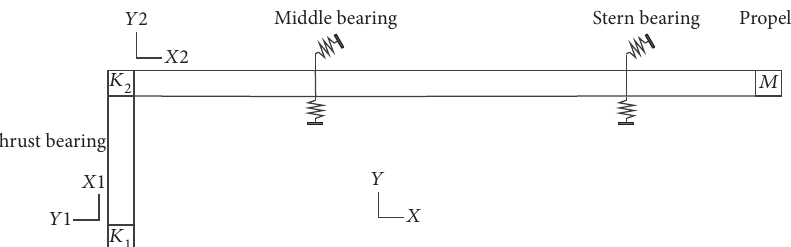
Thrust bearing Figure 8: The propulsion shafting with multisupport